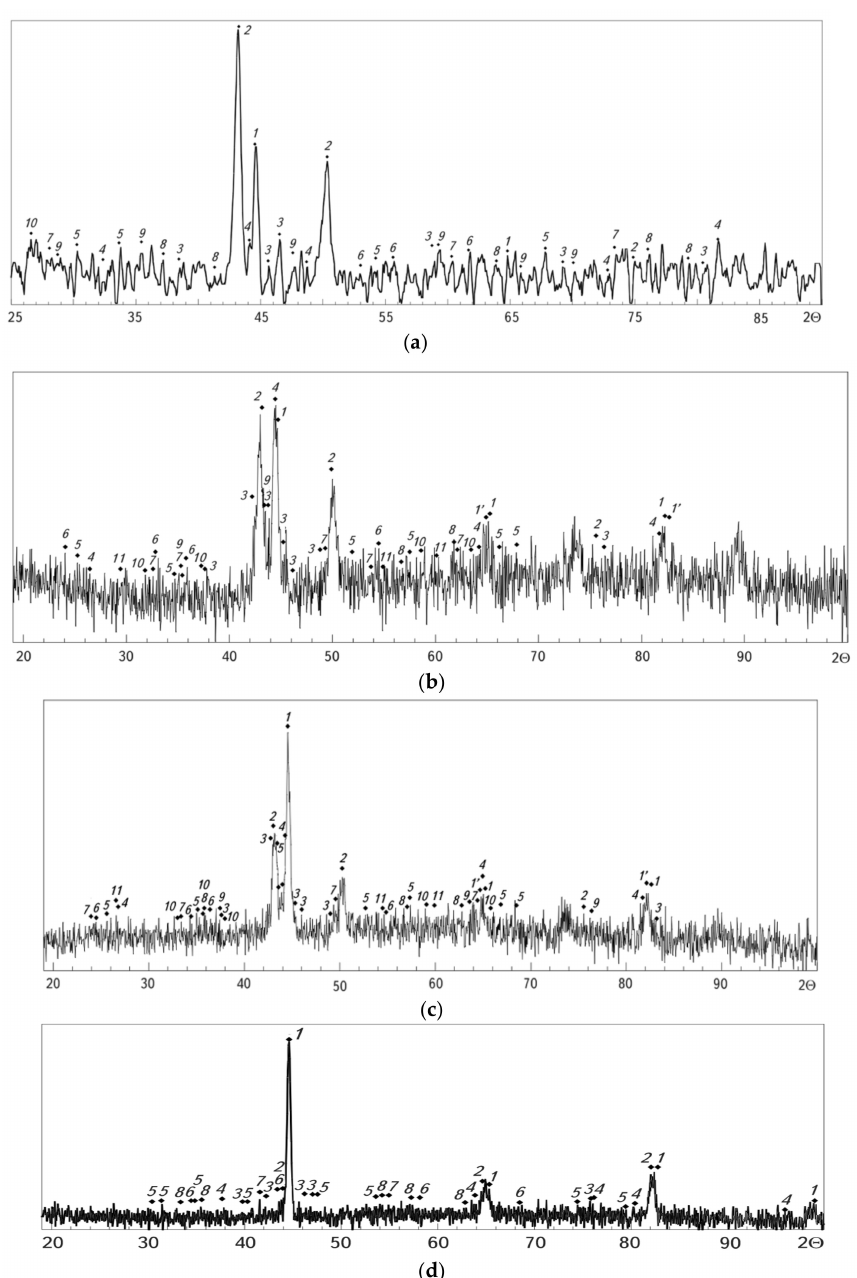
Figure 10. X-ray diffraction patterns of arc coatings of the system (FeCrC + Al) sprayed with CW, the charge of which contained different amounts of aluminum, wt. %: ( a ) 2: 5, 1 —Fe α (m) ; 2 —Fe γ (residual austenite); Traces: 3 —Fe 3 C; 4 —Cr 7 C 3 ; 5 —Cr 2 O 3 ; 6 —Fe 3 O 4 ; 7 —FeO; 8 —CrN; 9 —AlN; and 10 —graphite; ( b ) 5: 1 —Fe α (f) + Fe α (m) ; 2 —Fe γ (residual austenite); Traces: 3 —Fe 3 C; 4— Fe 3 Al; 5 —Al 2 O 3 ; 6 —Cr 2 O 3 ; 7 —Fe 2 O 3 ; 8 —Fe 3 O 4 ; 9 —CrN; 10— AlN; and 11 —graphite; ( c ) 15: 1 —Fe α (f) + Fe α (m) ; 2— Fe γ (residual austenite); Traces: 3— Fe 3 C; 4— Fe 3 Al; 5 —Al 2 O 3 ; 6 —Cr 2 O 3 ; 7 —Fe 2 O 3 ; 8 —Fe 3 O 4 ; 9— CrN; 10 —AlN; and 11 —graphite and ( d ) 20: 1 —Fe α (f) + Fe α (m) ; Traces: 2 —Cr; 3 —FeCr; 4 —CrN; 5 —Fe 2 P; 6 —Al 2 O 3 ; 7 —Cr 2 O 3 ; and 8— Fe 2 O 3